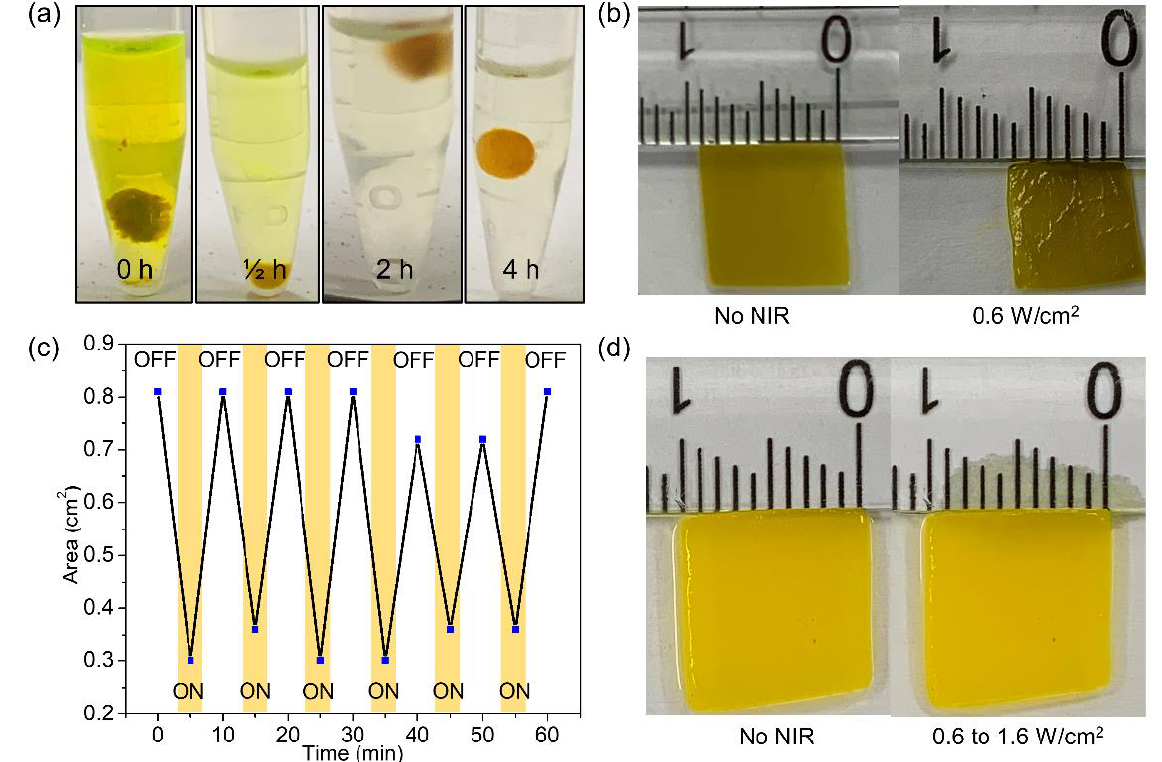
Figure 4. ( a ) Heat treatment of nanofiber under 160 ◦ C. ( b ) Digital images of the area changes of the whole nanofiber containing GNRs upon irradiation of NIR light. ( c ) Change in area of the whole nanofiber containing GNRs as a function of cycles of temperature alternation upon the NIR irradiation. ( d ) Digital images of the area of the whole nanofiber without GNRs in the presence and absence of NIR light irradiation.